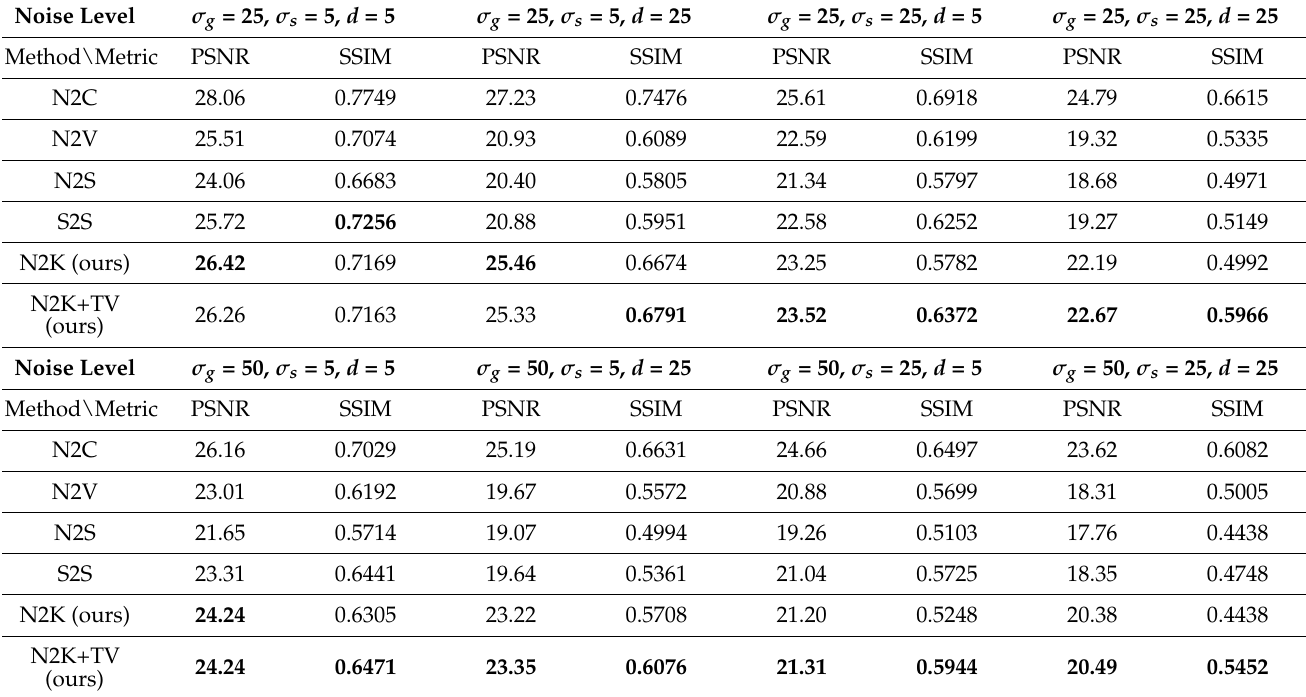
Table 2. Performance of baselines, the proposed method and the proposed method+TV on the Set14 test set. Boldface denotes the best among all except